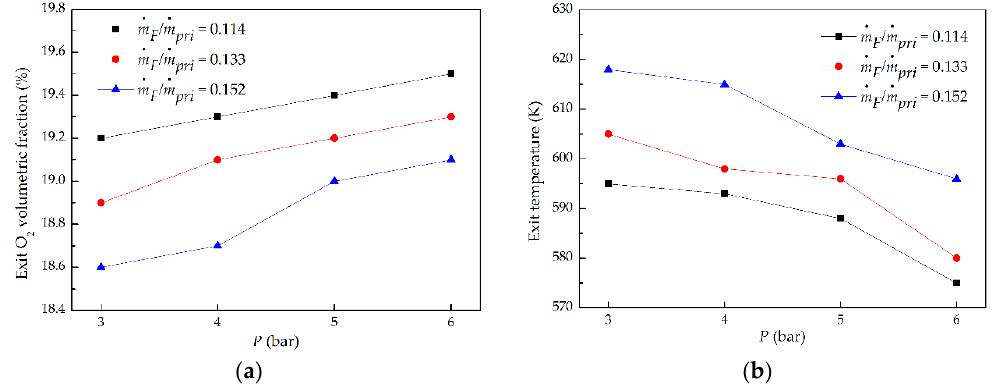
Figure 9. ( a ) Exit gas O 2 volume fraction; ( b ) exit temperature